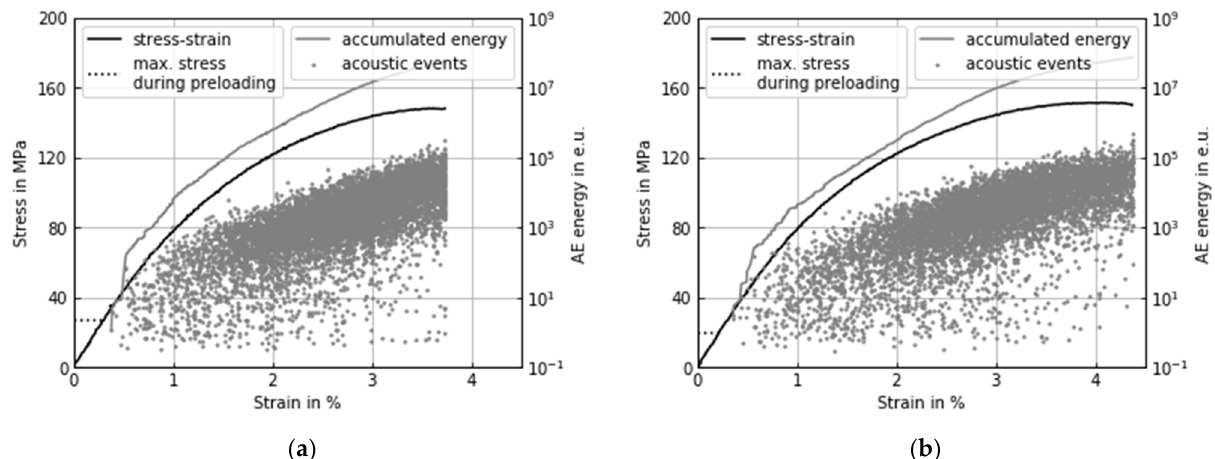
Figure 5. Stress–strain curve, acoustic energy and accumulated acoustic energy in energy units (1 e.u. ≙ 1×10 −21 J) of preloaded specimens: σ max = ( a ) 26.6 MPa; ( b ) 20.0 MPa.